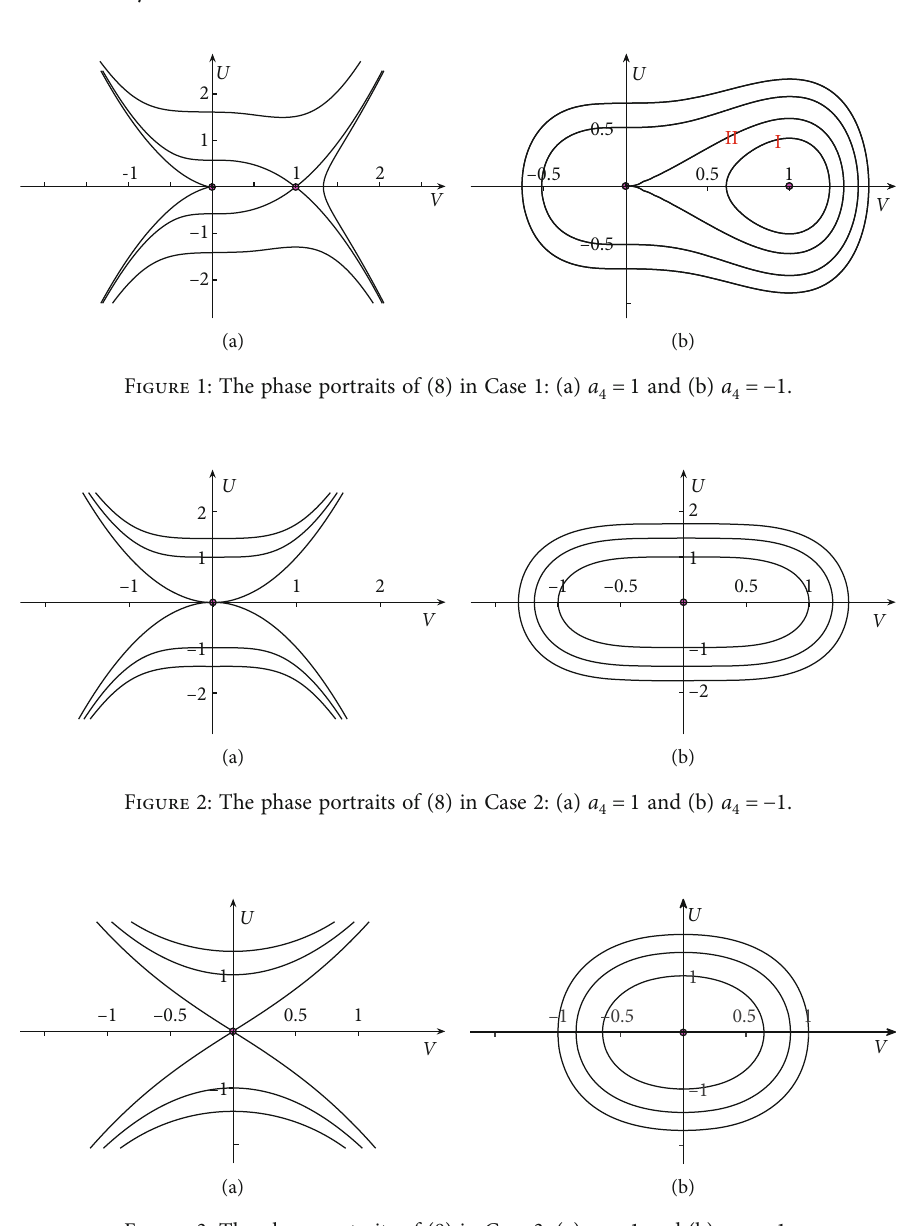
Figure 3: The phase portraits of (8) in Case 3: (a) a